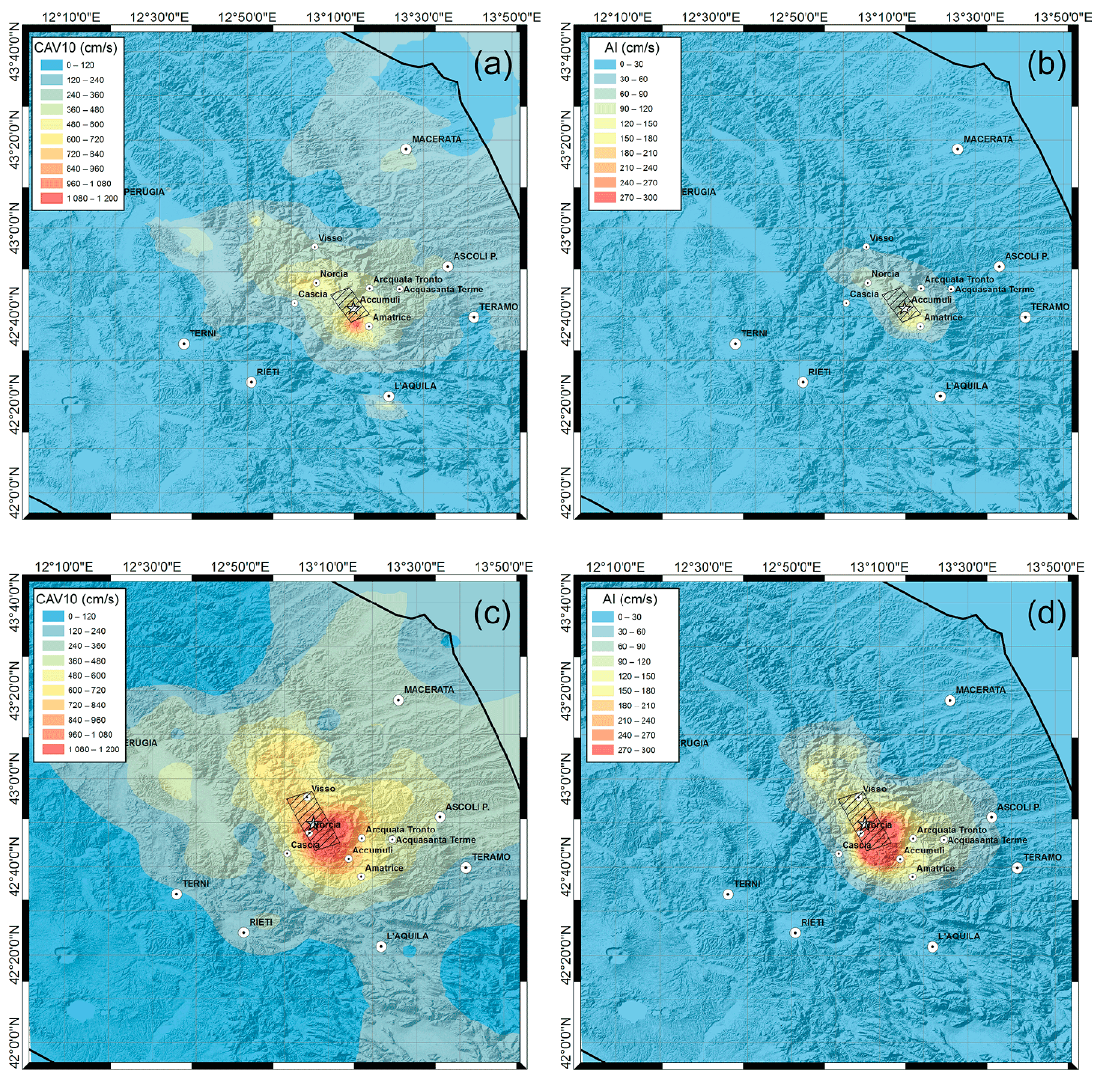
Figure 7. Interpolation of CAV10 and AI through the best-fitting models obtained for the M W 6.0. Amatrice earthquake ( a , b ) and the M W 6.5 Norcia earthquake ( c , d ). White stars are the epicenters (http://cnt.rm.ingv.it/) and dashed rectangles indicate the faults projected on the surface (http://shakemap.rm.ingv.it/).